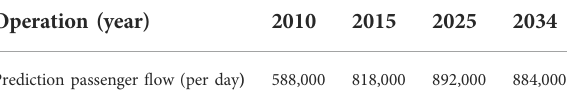
TABLE 2 Prediction data for Beijing Metro Line